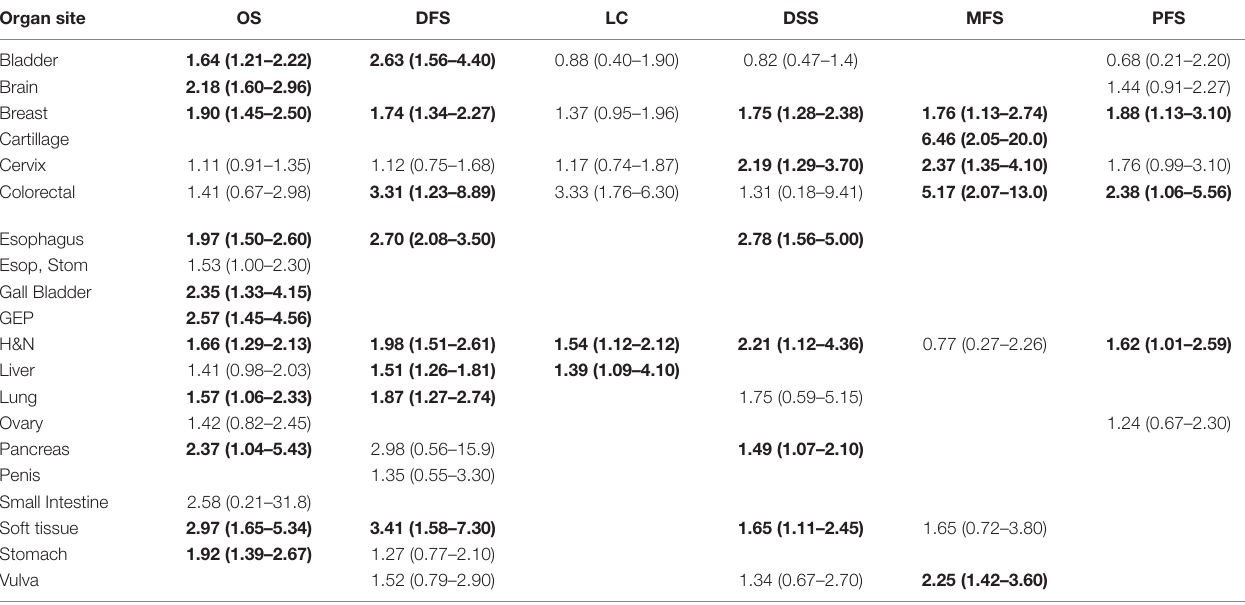
TABLe 1 | Results of subgroup meta-analyses of different organ sites